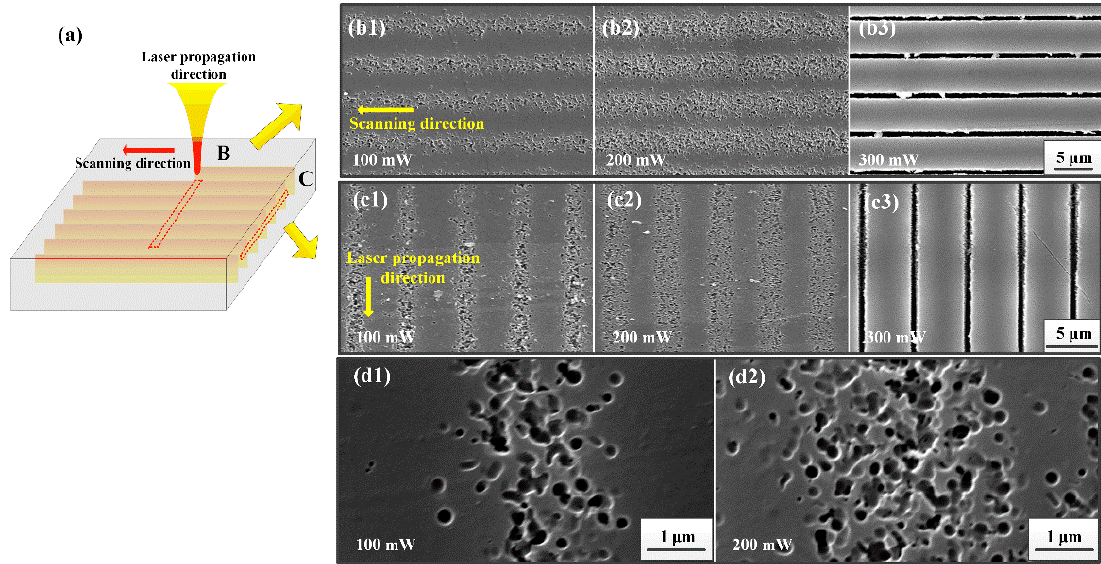
Figure 3. Schematic diagram of Bessel beam propagation inside PTR glass ( a ). SEM images of nano-crystal formation along scanning direction ( b ) and along propagation direction ( c ) with different writing powers. The analysis was performed after HF etching. Note the change in the trace morphologies between low and high power regimes. Magnified views ( d ) of laser scanning direction with writing powers of 100 and 200 mW.